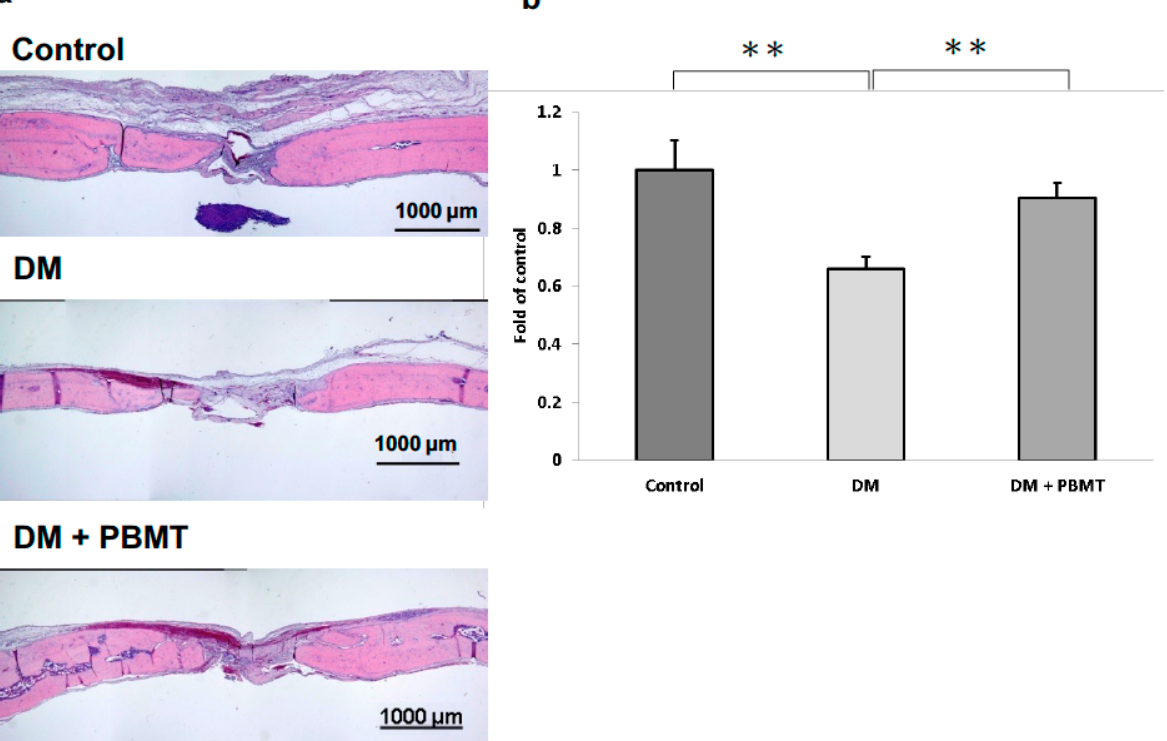
Figure 3. H&E staining of the cross section of the calvarial defects at Week 12 post-operation. ( a ) Representative H&E staining images of calvarial bone sections from each group: Control, DM, and DM + PBMT treatment. Calvarial bone defects (3 mm) were generated in adult Wistar rats. PBMT treatment (4 J/cm 2 ) were applied daily. The calvarial bone sections were collected at Week 12 postoperatively and stained using H&E. Scale bar, 1000 μ m. ( b ) Quantitative measurements obtained from H&E-stained images. The new bone formation area in the calvarial defect site was measured and the percentage of bone matrix within the callus was calculated. Data were expressed as means ± SD, ** p < 0.001.